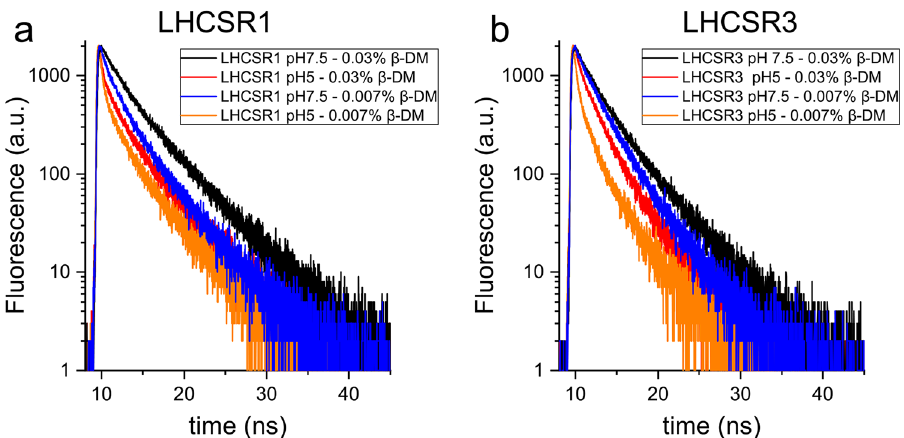
Figure 5. Time resolved fluorescence decay kinetics decay of reconstituted LHCSR1 and LHCSR3 recombinant proteins. LHCSR1 ( a ) and LHCSR3 ( b ) fluorescence decay kinetics were measured at 685 nm with excitation at 447 nm. The data herein reported are representative of two independent experiments. The figure was prepared by using OriginPro 2018 software https ://www.origi nlab.com/.